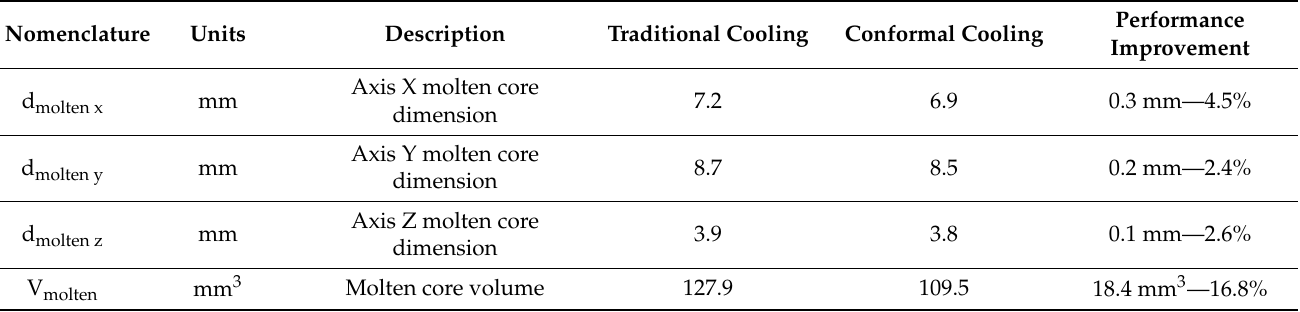
Figure 23. Molten core at the ejection time. ( A ) Traditional cooling; ( B ) conformal cooling. Table 10. Molten core dimensions and volume at the ejection time for the conformal and traditional cooling systems.